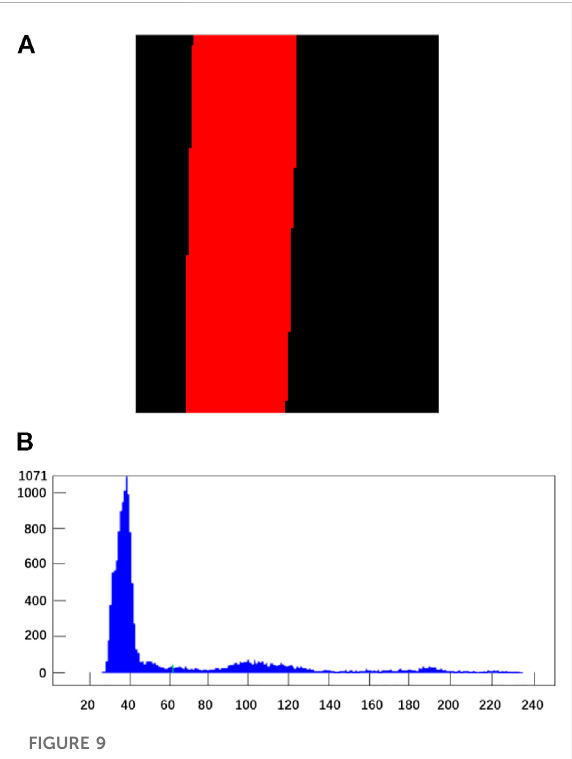
FIGURE 9 image Segmentation processing diagram of winding